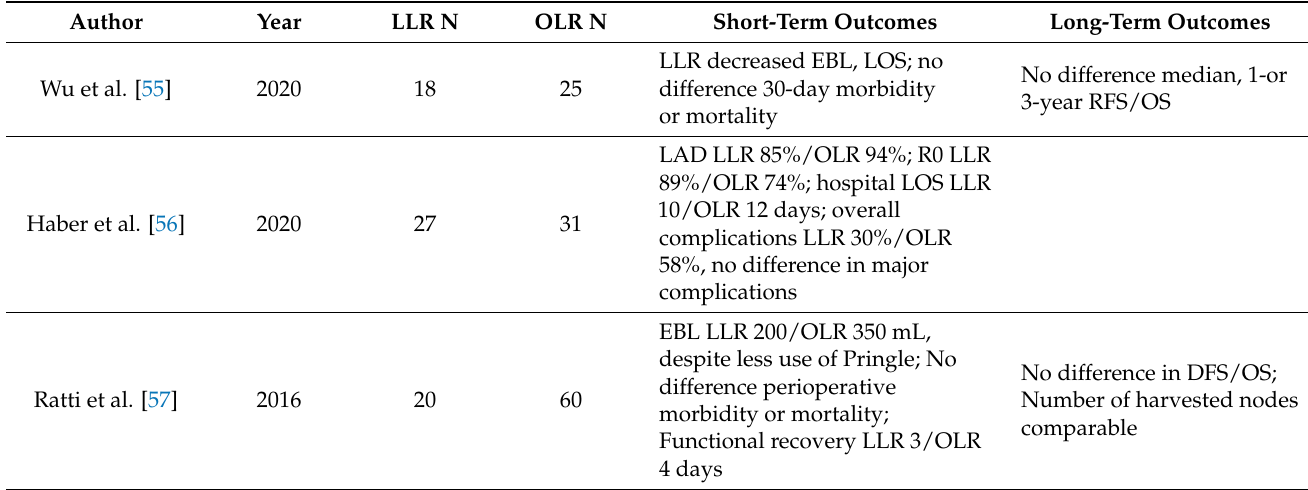
Table 2. Selected references: laparoscopic versus open liver resection for intrahepatic